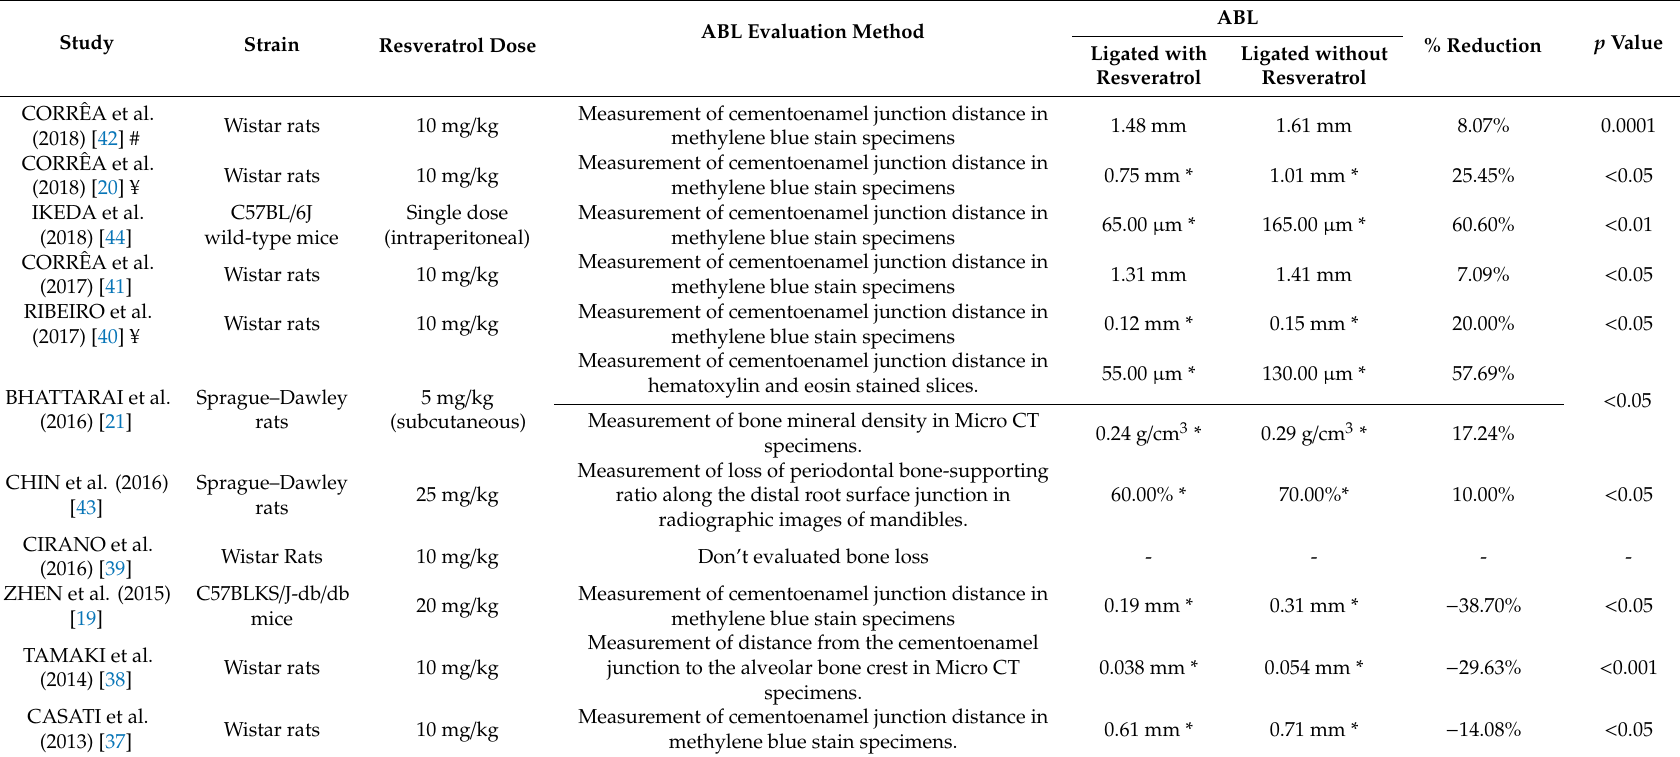
Table 2. A reduction of the bone loss in rodents with periodontal disease and treated with